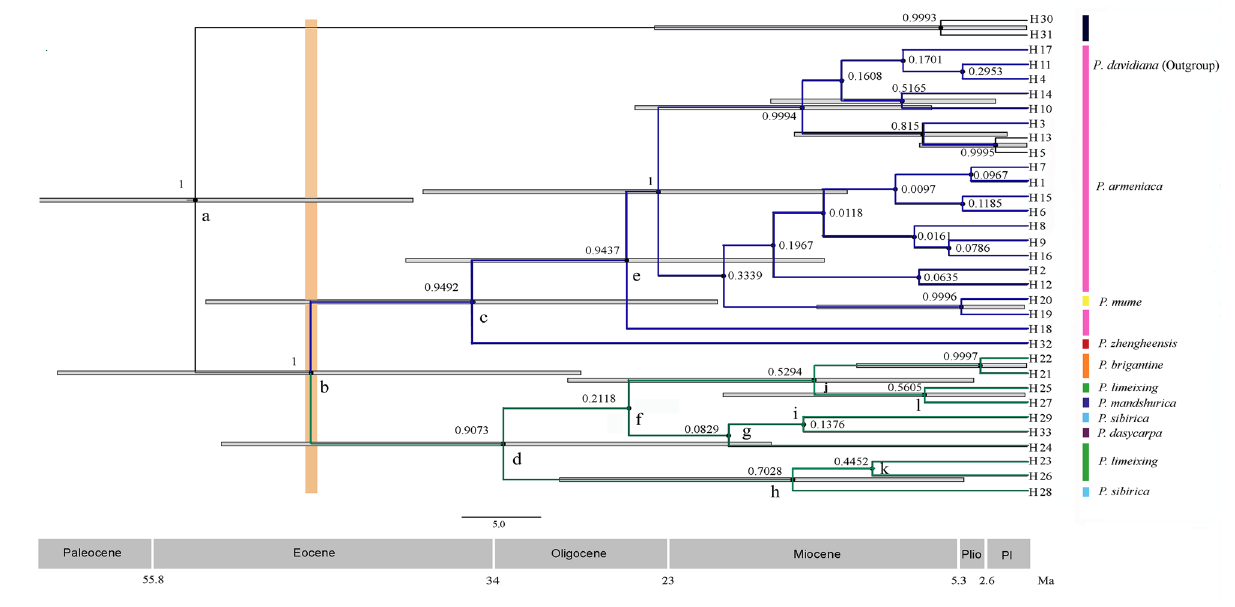
Figure 5. Best-derived chronogram of Prunus spp. based on chloroplast DNA. Gray bars represent 95% highest posterior density intervals. The numbers on the branches are posterior probabilities (PP > 0.9). Plio, Pliocene; Pl, Pleistocene; numbers above the branches indicate Bayesian posterior